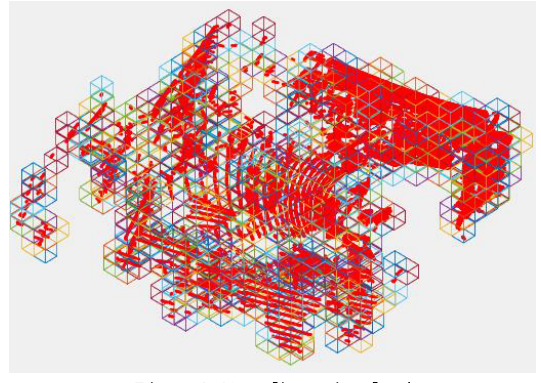
Figure 2- Voxelize point cloud